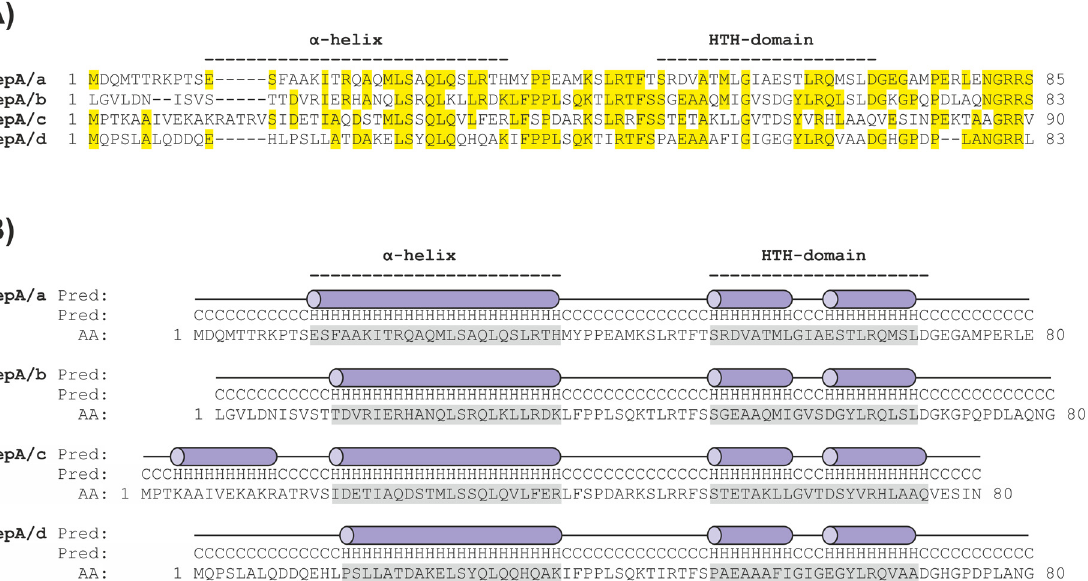
Fig 3. Amino acid sequence analysis of RepA proteins of RtTA1 plasmids. (A) Multiple alignment of N-terminal sequences of RepA/a-d. Identical amino acid residues were marked in yellow. (B) Secondary structure predictions of N-termini of individual RepA proteins. The regions constituting the α -helices responsible for RepA dimerization and helix-turn-helix (HTH) DNA binding domains were presented as blue cylinders and highlighted in